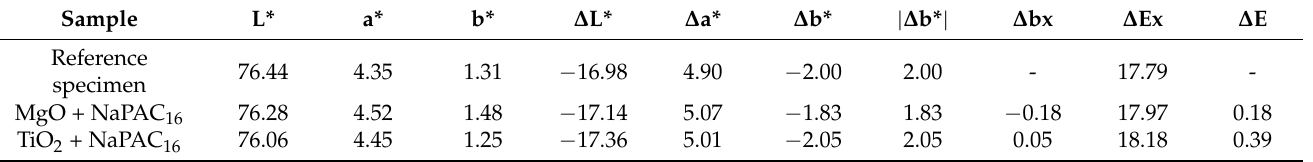
Table 10. Colorimetric parameters measured on red bricks samples before and after 15 min immersion in specific dispersion. Sample